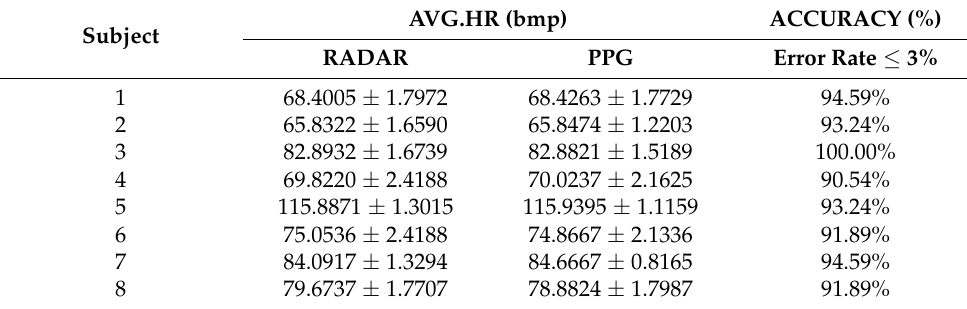
Table 2. Average heart rate measurement